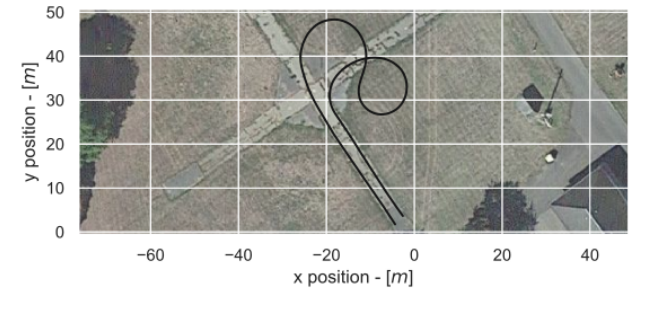
Figure 5. The trajectory.